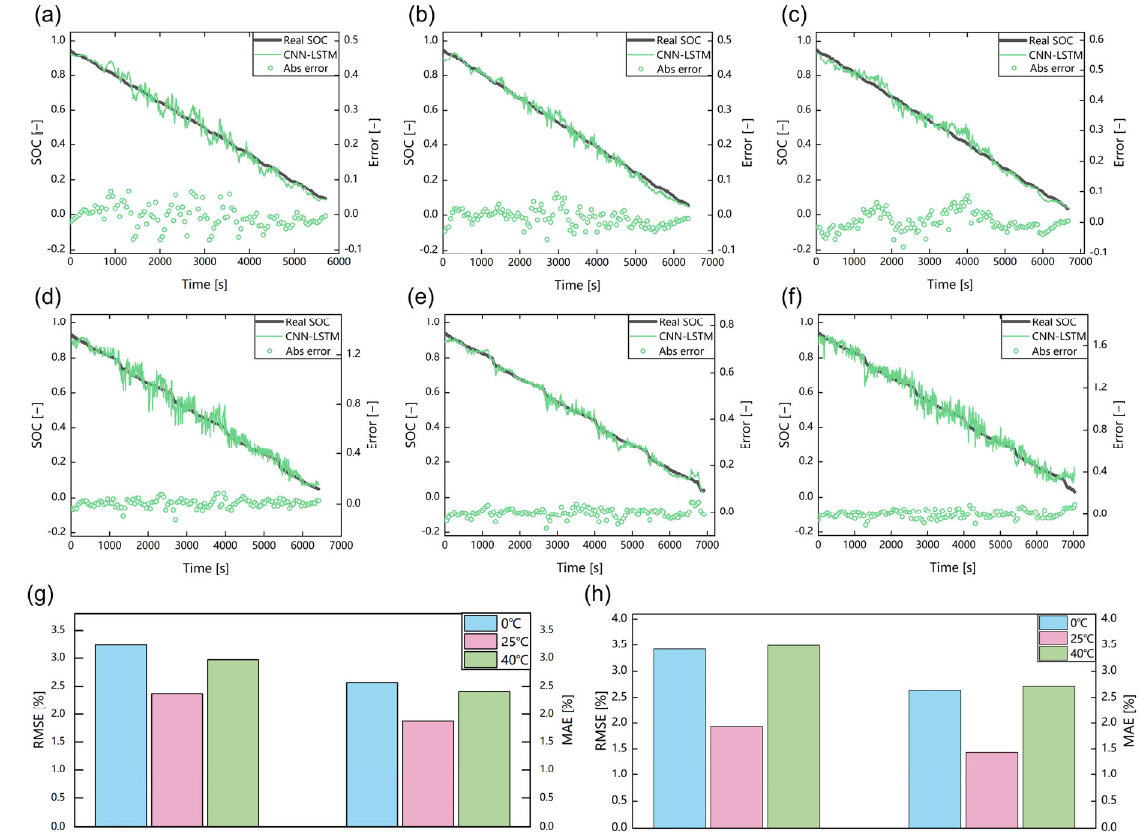
Figure 5. SOC estimation results with CNN ‐ LSTM under different temperatures: ( a – c ) donate the estimation results for US06 driving cycle under 0 °C, 25 °C and 40 °C, respectively; ( d – f ) donate the estimation results for US06 driving cycle under 0 ◦ C, 25 ◦ C and 40 ◦ C, respectively; ( d – f ) donate the estimation results for FUDS driving cycle under 0 °C, 25 °C and 40 °C, respectively; ( g , h ) donate the estimation results for FUDS driving cycle under 0 ◦ C, 25 ◦ C and 40 ◦ C, respectively; ( g , h ) donate the RMSE and MAE analysis for US06 driving cycle and FUDS driving cycle, respectively. RMSE and MAE analysis for US06 driving cycle and FUDS driving cycle,